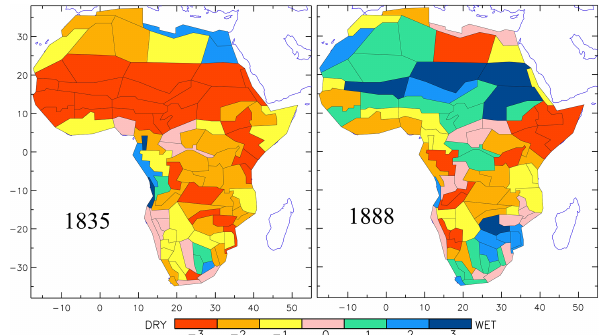
Figure 6. Rainfall anomaly patterns for 1835 and 1888 for the 90 homogenous rainfall regions of Africa delineated on the maps (modified after Nicholson et al.,